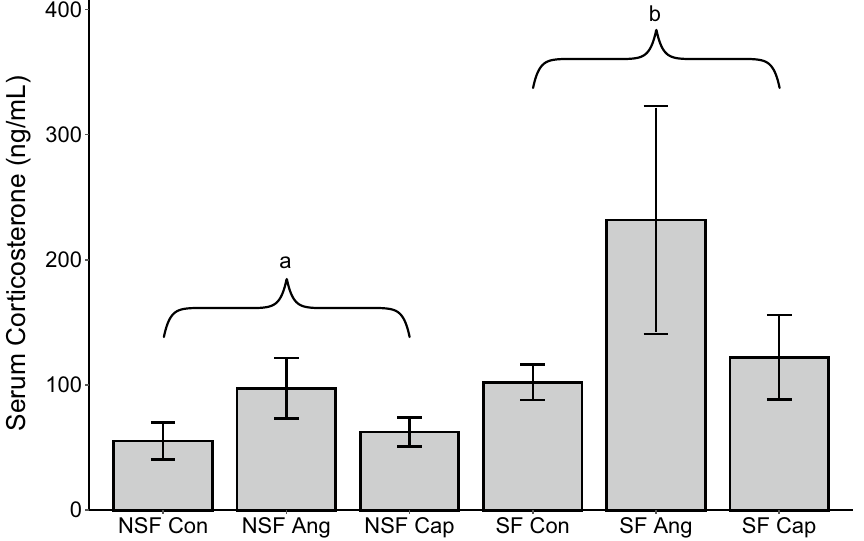
Figure 5. Effects of sleep fragmentation, RAS manipulation, and their interaction on plasma corticosterone levels. Samples sizes are NSF-Con n = 11, NSF-Ang n = 8, NSF-Cap n = 10, SF-Con n = 8, SF-Ang n = 8, and SF-Cap n = 10 and were analyzed using a two-way ANOVA and Tukey’s HSD post hoc tests. Data shown as means ± 1 SE for each group and lowercase differing letters denotes p <